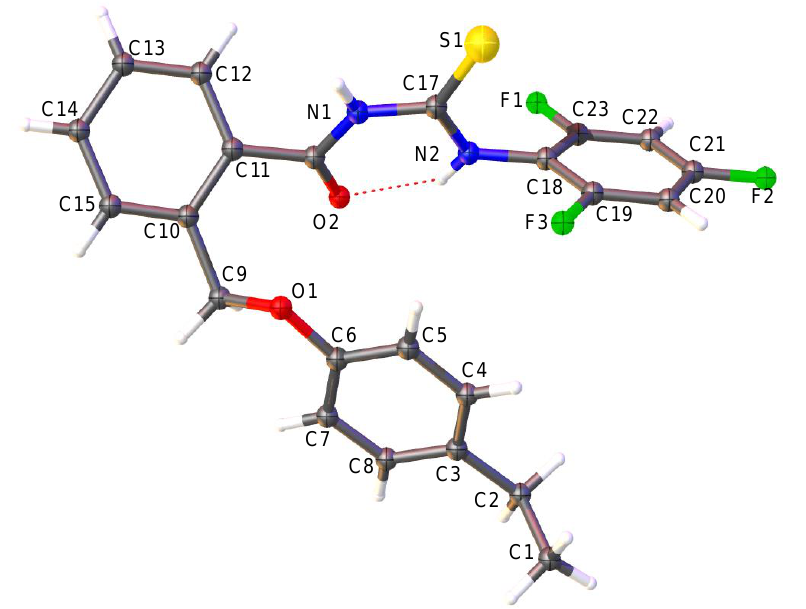
Figure 2. View of the asymmetric unit for 5d with the atom numbering scheme (50% probability ellipsoid).